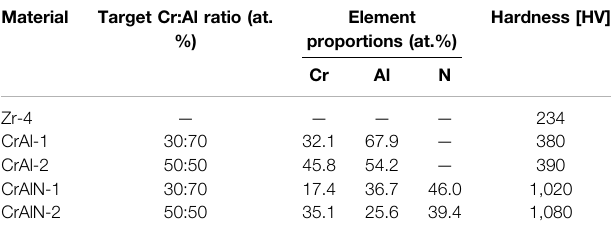
TABLE 1 | Concentration of Cr, Al, and N in the CrAl-based coatings and echanical properties for ATF candidates and Zr-4. Material Target Cr:Al ratio (at. Element %) proportions